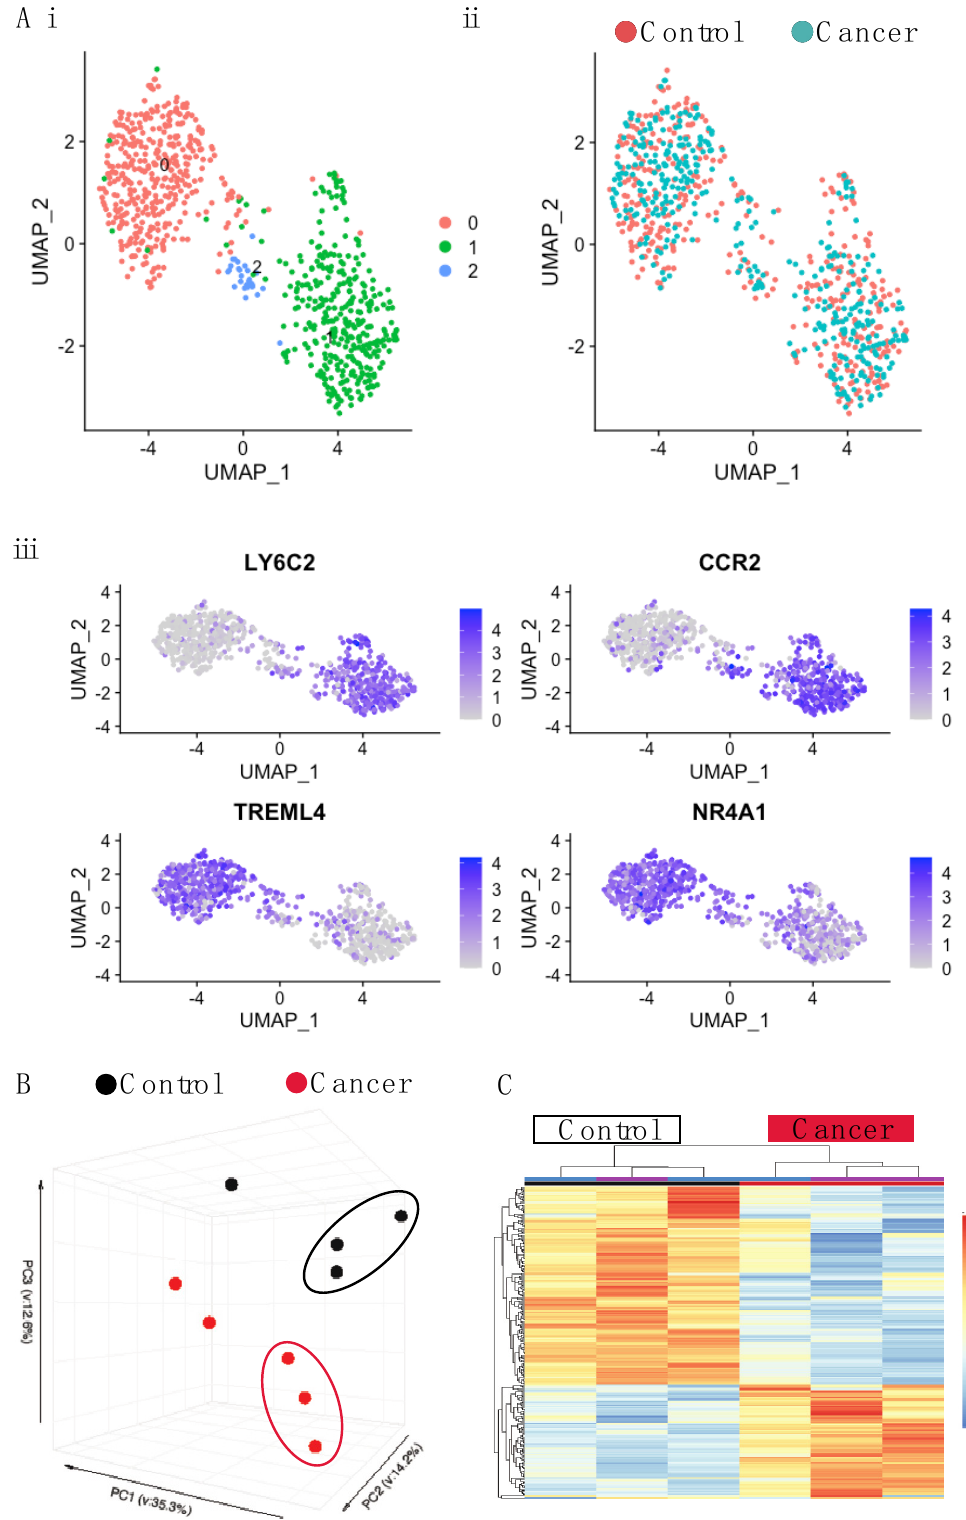
Figure 4. Single cell and bulk RNA-seq of blood monocytes in C57BL/6 mice with late stage cancer. ( A ) UMAP plot for single cell sequencing (SCseq) of total monocytes cells from control and cancer- bearing mice. ( i ) Distribution of all monocytes combined shows three populations: pink, blue, and green. ( ii ) Distribution of control monocytes (pink) and tumor (blue). ( iii ) Marker analysis showing classical (LY6C2, CCR2) and non-classical (TREML4, NR4A1) monocytes. ( B ) PCA of gene expres- sion derived from bulk RNAseq of Ly6C high Monocytes. ( C ) Gene expression heatmap of Ly6C high